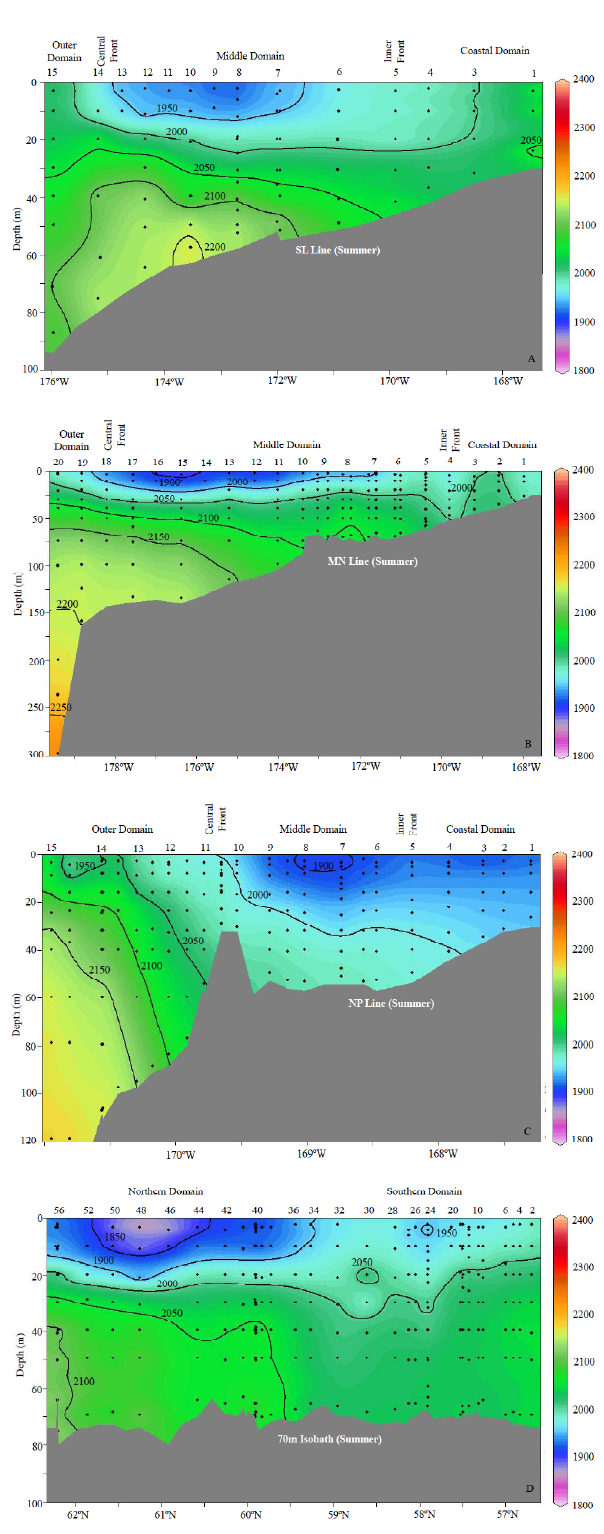
Fig. 6. Summer DIC concentrations (µmoleskg − 1 ) along the four transect lines shown in Fig. 1. The domains and fronts as well as station numbers are shown across the top of each figure. A) SL line. B) MN Line. C) NP Line. D) 70m Line.